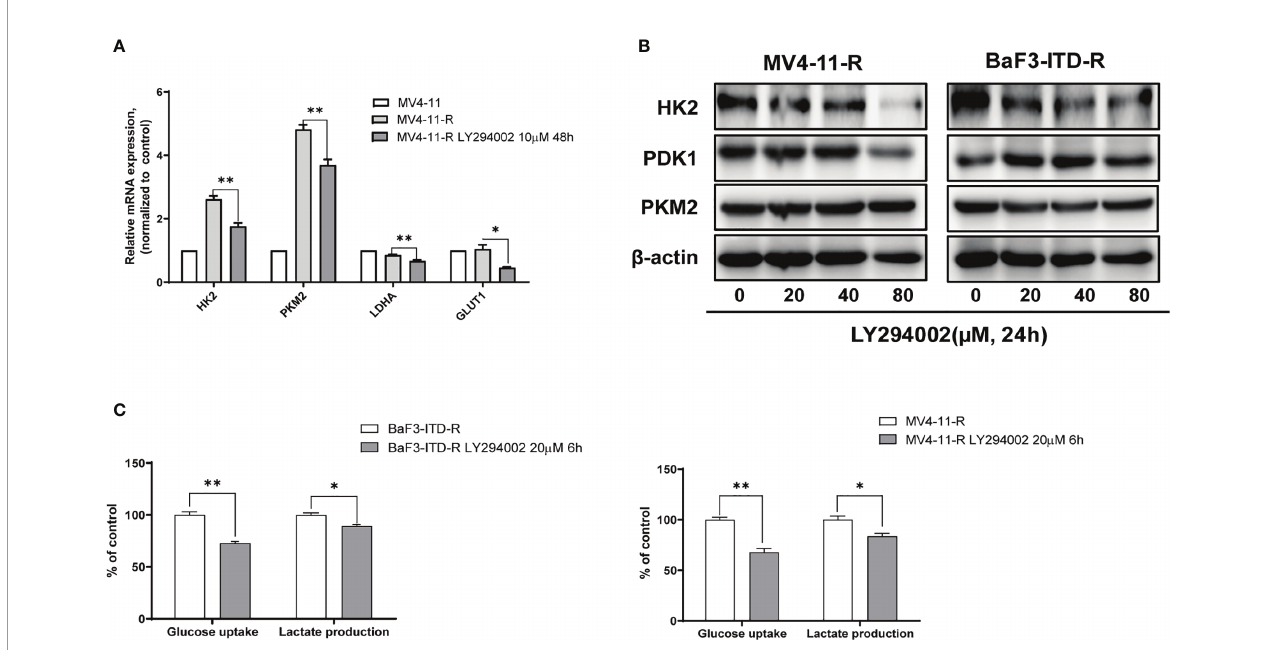
FIGURE 4 | Gene expression of glycolytic enzymes and ATP generation were diminished by LY294002 in the resistant cells. (A) Incubating the MV4-11-R cells with 10 m M LY294002 for 48 hours, and messenger ribonucleic acid (mRNA) level of HK2, PKM2, LDHA, GLUT1 were compared. (B) The sorafenib-resistant cells, MV4- 11-R and BaF3-ITD-R, were incubated with increasing concentrations of LY294002 for 24 hours, with the protein expression of HK2, PDK1 and PKM2 were evaluated by western blotting. b -actin was used as a loading control. (C) Glucose uptake and lactate production were evaluated when resistant cells were treated with 10µM LY294002 for 6 hours.*p < 0.05, **p <